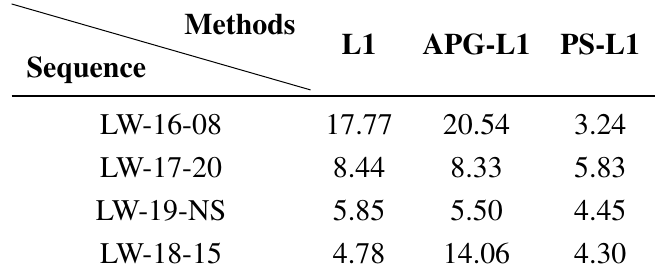
Table 1. Numerical Comparison of Average of PosErr.